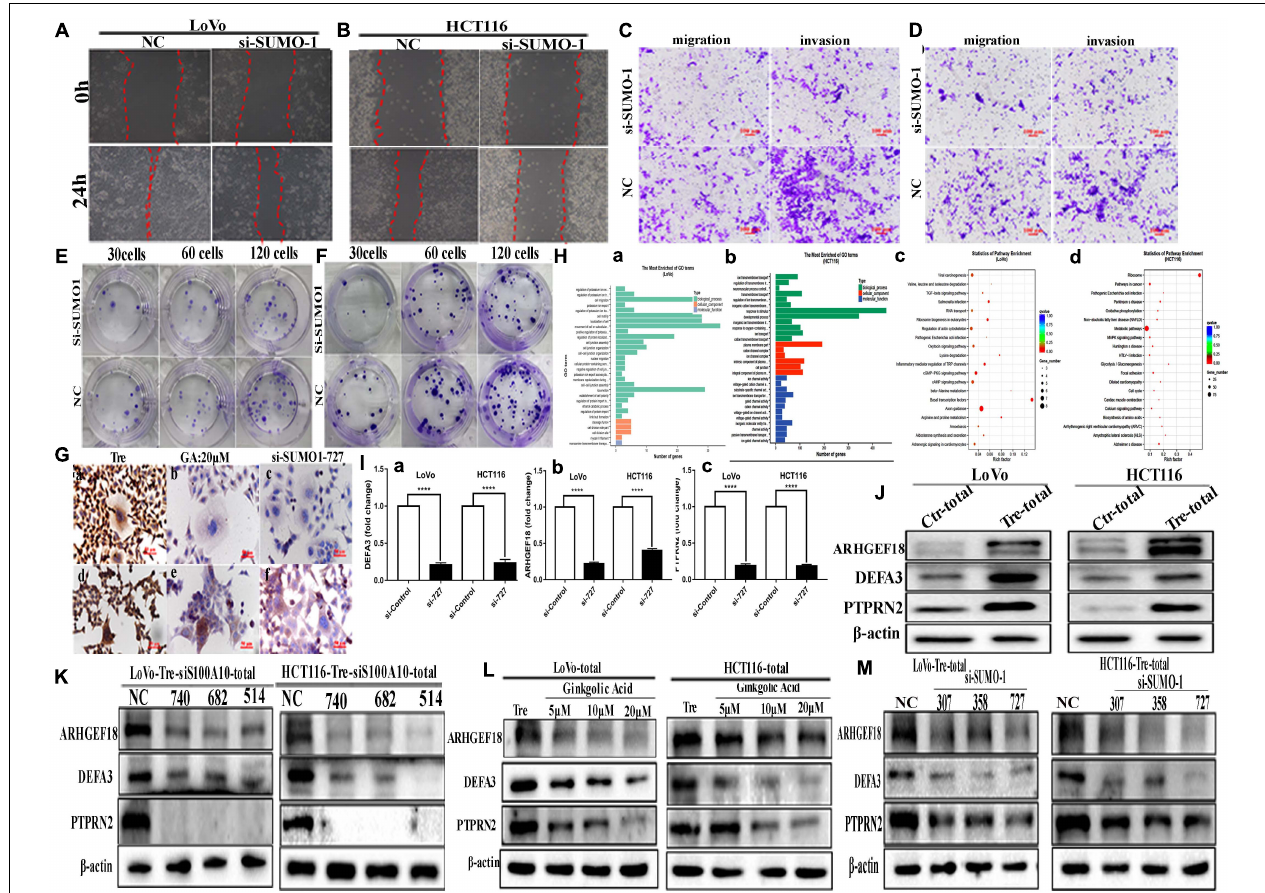
FIGURE 5 | The motility, invasiveness and migration of LoVo and HCT116 PGCCs and daughter cells before and after SUMO1 knockdown and the results of ChIP-Seq and real-time PCR in these cells. (A) Wound-healing assay in LoVo PGCCs with their daughter cells transfected with SUMO1-727 and control siRNAs. (B) Wound-healing assay in HCT116 PGCCs with their daughter cells transfected with SUMO1-727 and control siRNAs. (C) The abilities of migration and invasion in LoVo PGCCs with their daughter cells transfected with SUMO1-727 and control siRNAs (100 × ). (D) The migration and invasion ability in LoVo PGCCs with their daughter cells transfected with SUMO1-727 and control siRNAs (100 × ). (E) Colony formation in LoVo PGCCs with their daughter cells transfected with SUMO1-727 and control siRNAs. (F) Colony formation in HCT116 PGCCs with their daughter cells transfected with SUMO1-727 and control siRNAs. (G) ICC staining of S100A10 in the LoVo and HCT116 PGCCs with daughter cells (ICC, 400 × ). (a) ICC staining of S100A10 in LoVo PGCCs with daughter cells. (b) ICC staining of S100A10 in LoVo PGCCs with daughter cells after GA treatment at 20 µ M. (c) ICC staining of S100A10 in LoVo PGCCs with daughter cells after SUMO1-siRNA 727 transfection. (d) ICC staining of S100A10 in HCT116 PGCCs with daughter cells. (b) ICC staining of S100A10 in HCT116 PGCCs with daughter cells after GA treatment at 20 µ M. (c) ICC staining of S100A10 in HCT116 PGCCs with daughter cells after SUMO1-siRNA 727 transfection. (H) (a) GO functional enrichment of targets associated with S100A10 in the PGCCs with daughter cells of LoVo ChIP-seq peaks for biological process. (b) GO functional enrichment of targets associated with S100A10 in the PGCCs with daughter cells of HCT116 ChIP-seq peaks for biological process. (c) KEGG pathway clustering analysis of targets associated with S100A10 in the PGCCs with daughter cells of LoVo ChIP-seq peaks. (d) KEGG pathway clustering analysis of targets associated with S100A10 in the PGCCs with daughter cells of HCT116 ChIP-seq peaks. (I) Immunoprecipitated DNA before and after the knockdown of SUMO1 was analyzed using specific primers of DEFA3 , ARHGEF18 , and PTPRN2 . (a) DEFA3 , (b) ARHGEF18 , (c) PTPRN2 . (J) The total ARHGEF18, DEFA3, and PTPRN2 expression in LoVo and HCT116 cells before and after CoCl 2 treatment. (K) Total ARHGEF18, DEFA3, and PTPRN2 expression in LoVo PGCCs with daughter cells after transfection